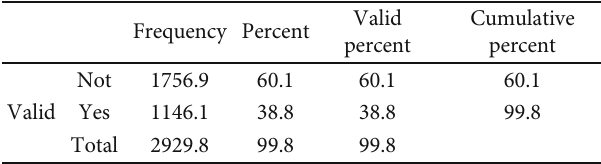
Table 1: Analysis of whether farmers will stay in urban development in the future.